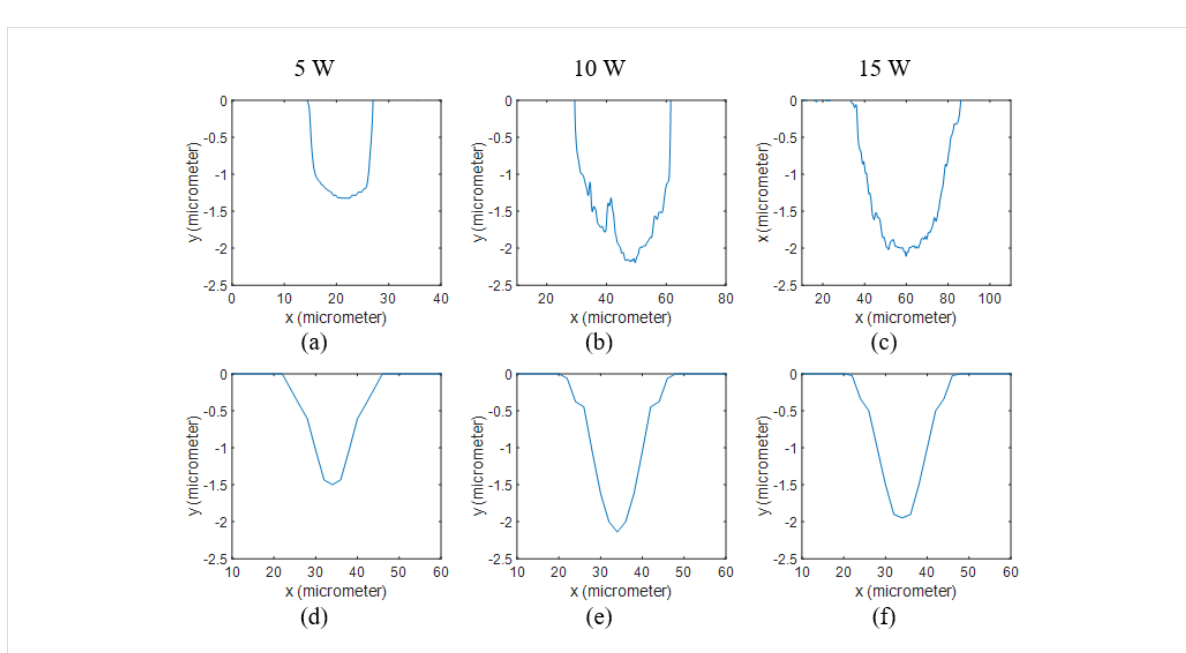
Figure 2: 2D profiles of uncoated Si samples processed at 50 kHz. Results obtained from measurements when using (a) 5 W, (b) 10 W and (c) 15 W are compared to the ones calculated through the numerical model at (d) 5 W, (e) 10 W and (f) 15 W.